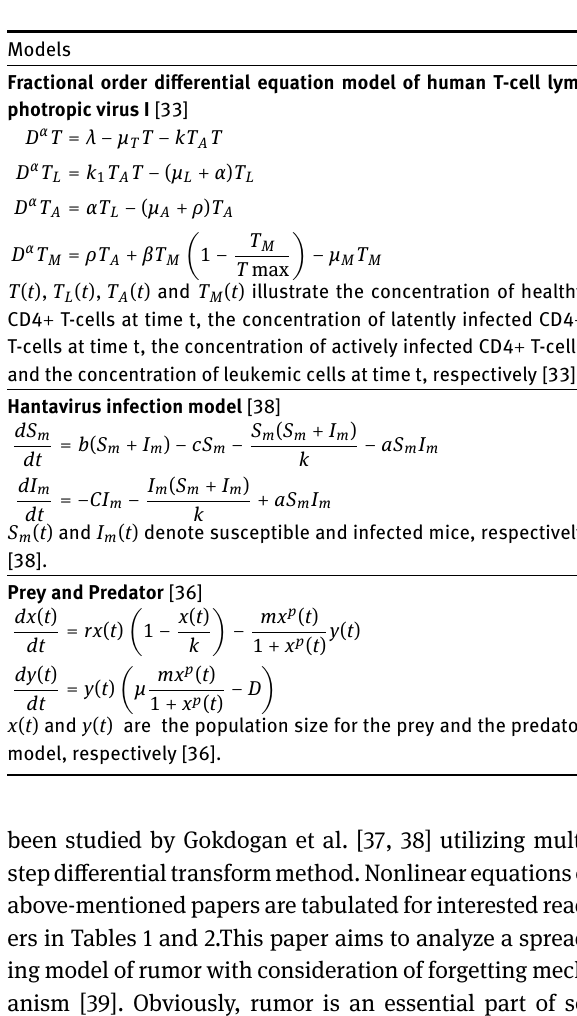
Table 2. Biomathematics and epidemic models that have been in- vestigated by analytical methods such as VIM, ADM, ETDM, HPM and